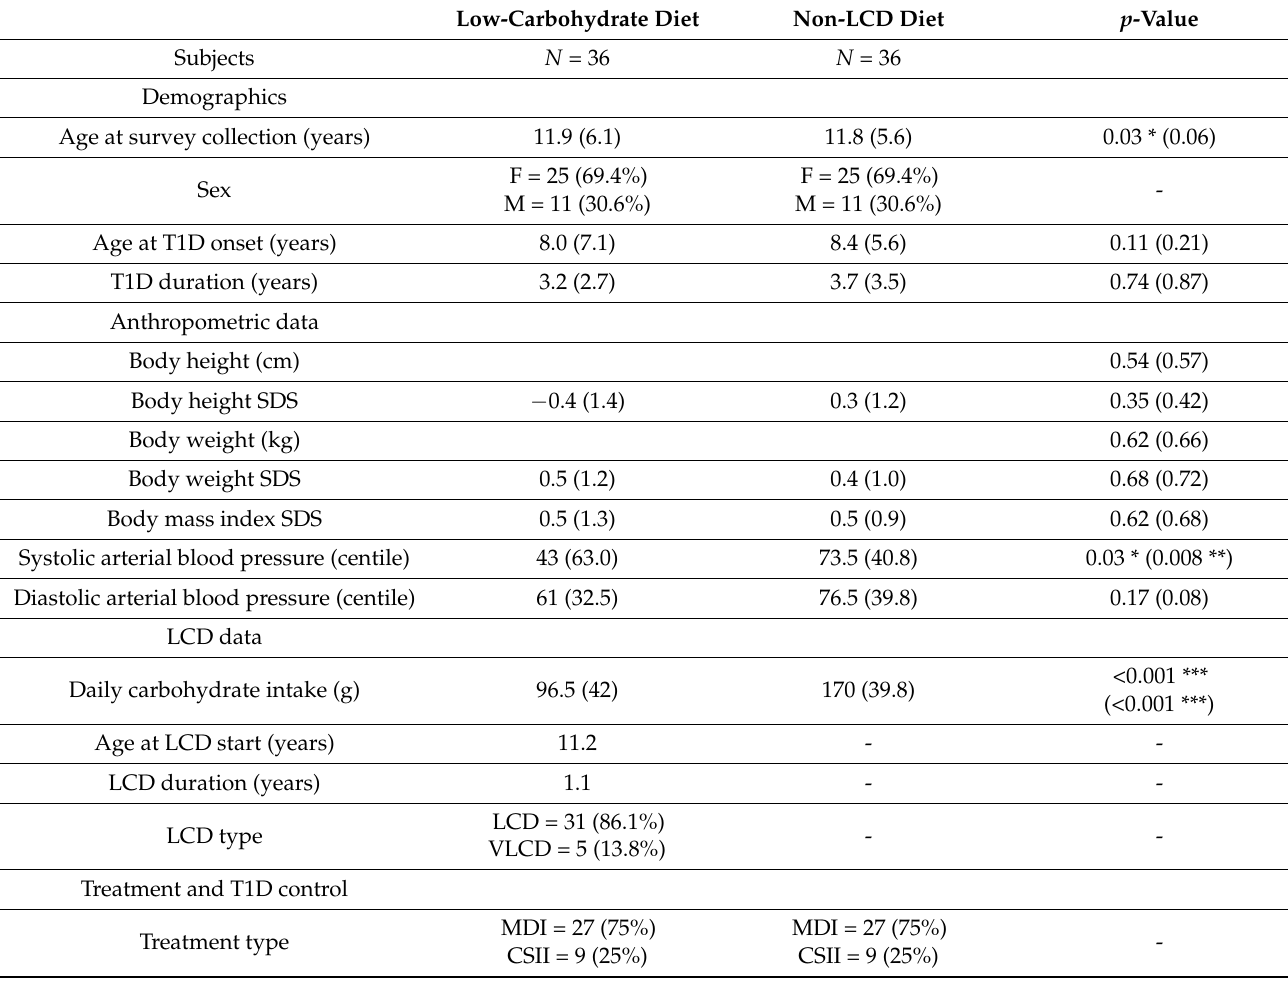
Table 1. Descriptive characteristics of the currently on total low-carbohydrate diet group, data are shown as median (IQR). Low-Carbohydrate Diet Non-LCD